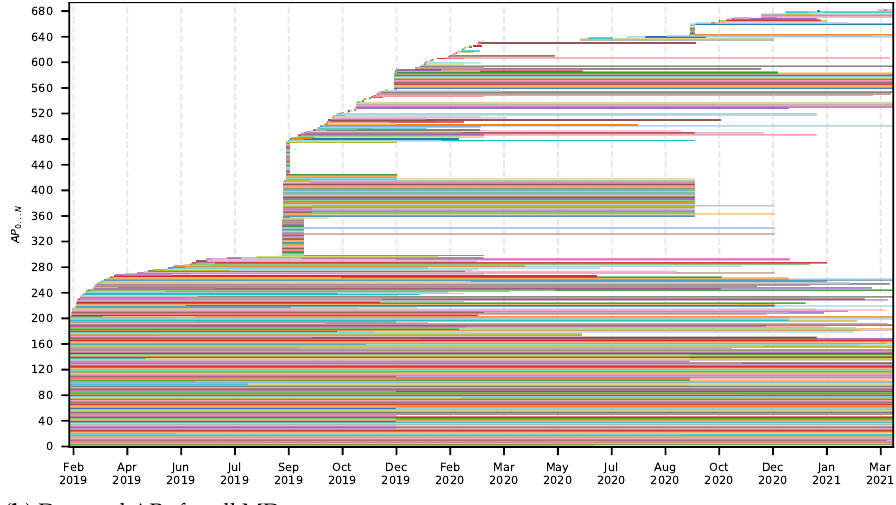
Figure 10. APs observed over